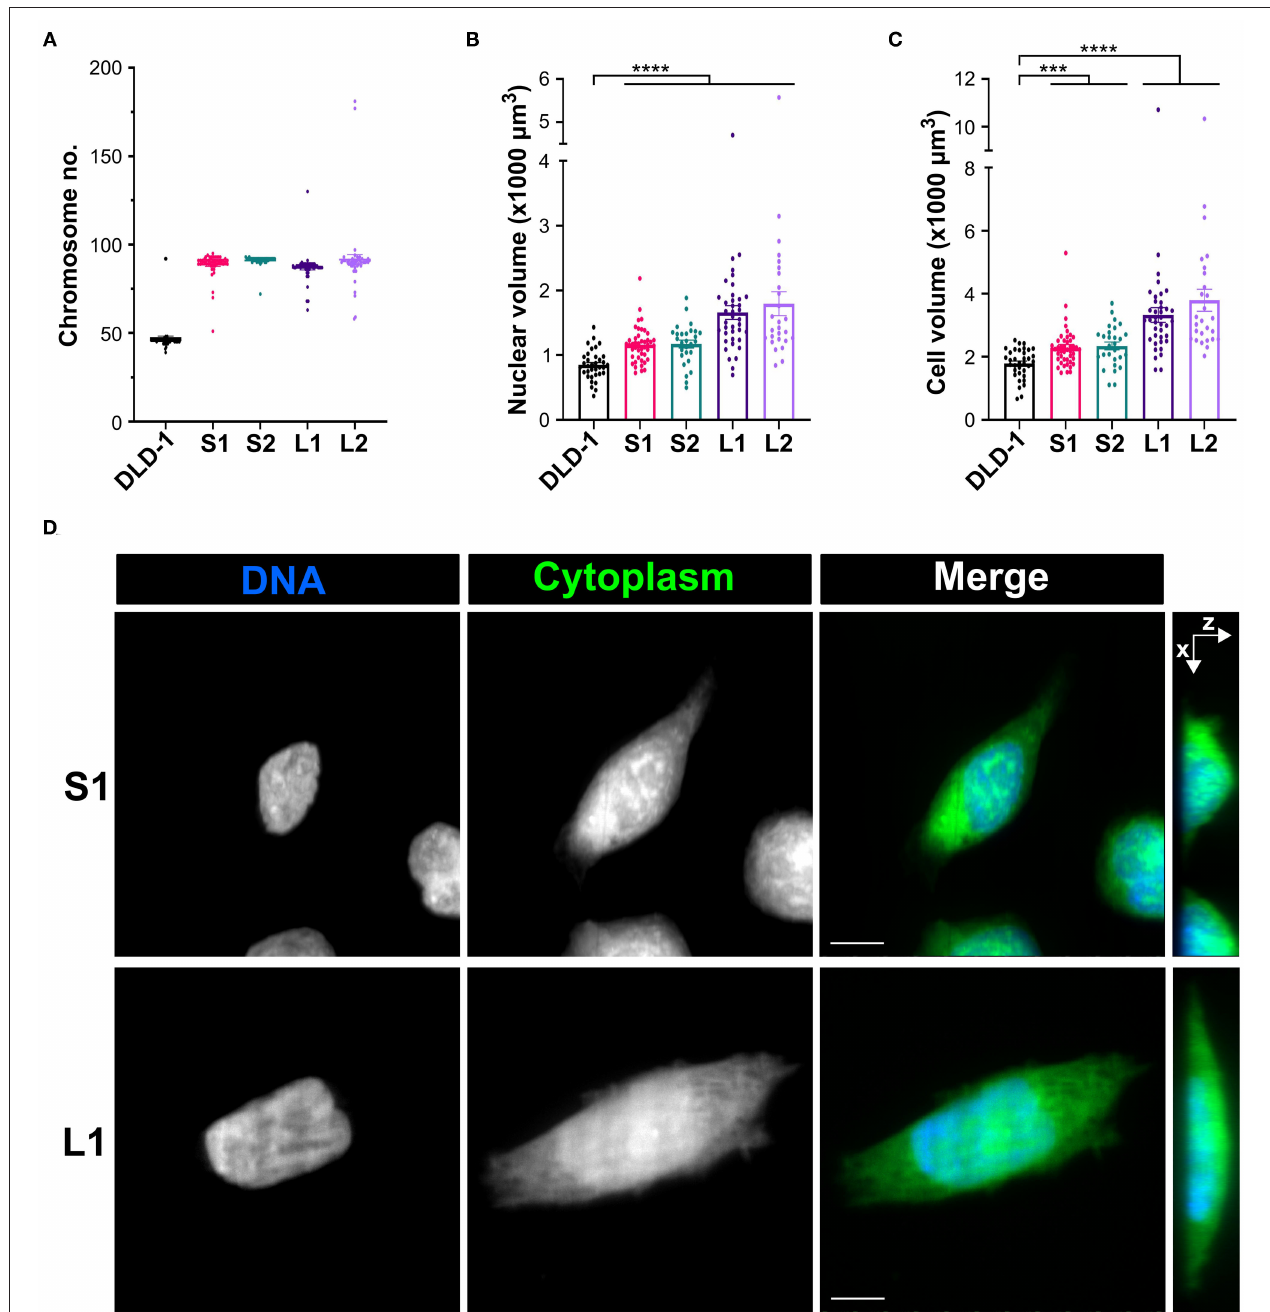
FIGURE 1 | Tetraploidization has a variable effect on cell and nuclear volume in DLD-1 cells. (A) Analysis of chromosome number to confirm ploidy in DLD-1 cells and derived tetraploid clones ( n 50 for each). (B) Nuclear and (C) cell volume measurements in parental DLD-1 cells and 4N DLD-1 clones synchronized in G2. Data are = reported as mean SEM with individual data points from three independent experiments in which a total of 27–44 cells ( n ± were analyzed. *** p < 0.001, **** p < 0.0001, when compared to the parental DLD-1 cells by Student’s t -test. (D) Examples of S1 (top) and L1 (bottom) cells used for nuclear (blue) and cell (green) volume analysis. Images are maximum intensity projections from Z -stacks along the X – Y coordinates (left three columns) or along the X – Z coordinates (right column). All scale bars, 10 µ m.